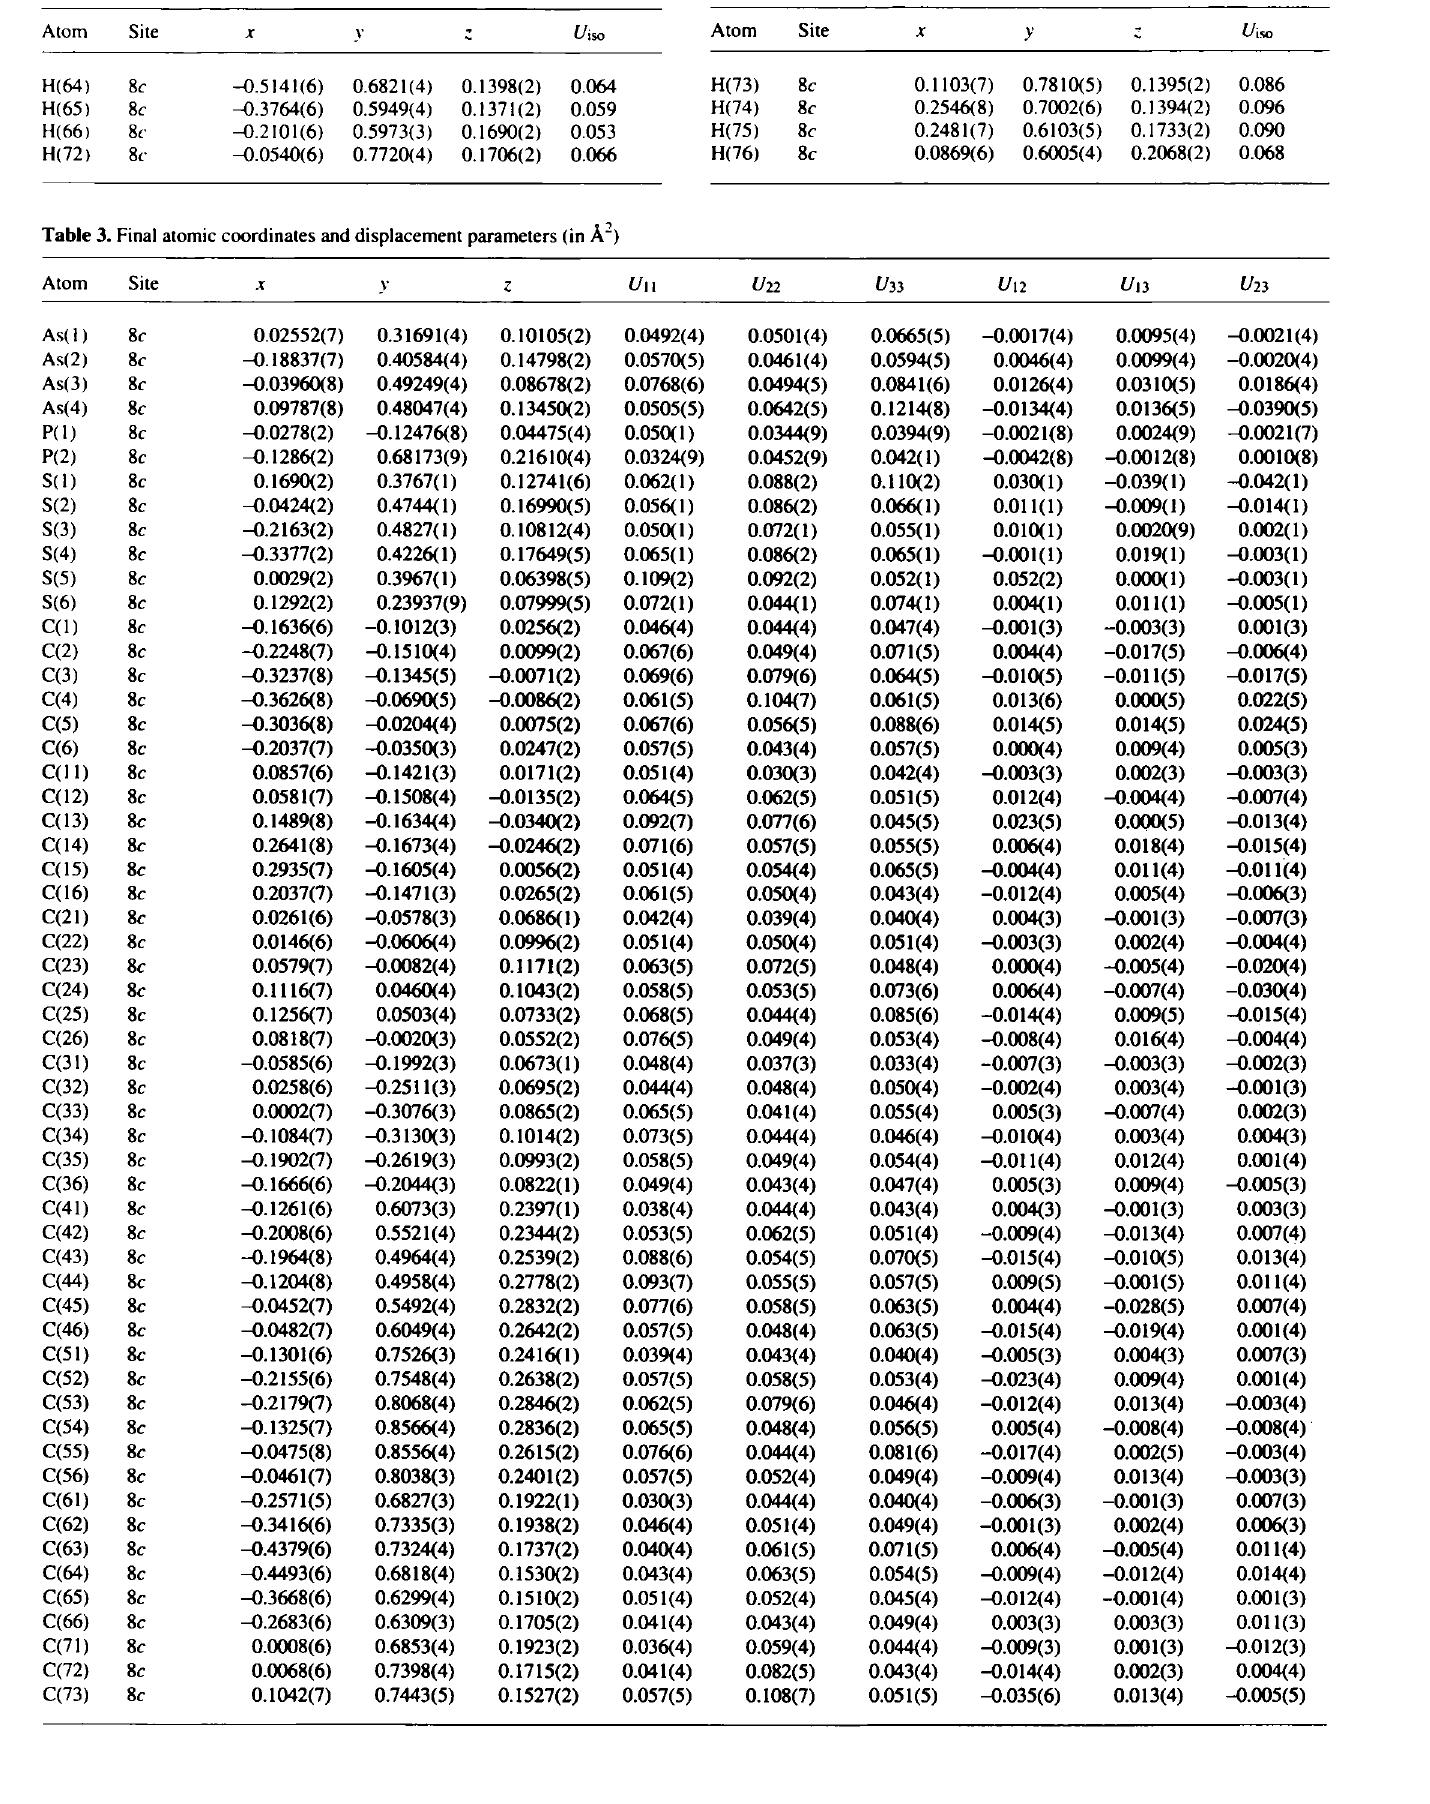
Table 3. Final atomic coordinates and displacement parameters (in